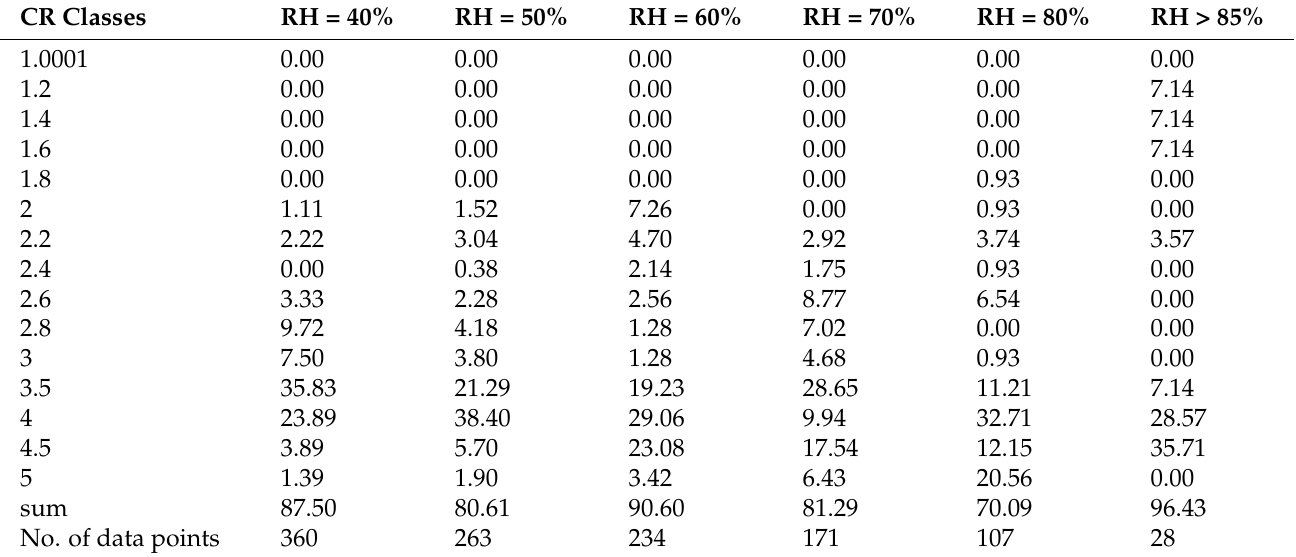
Table A2. Relative frequencies of the colour ratio between 1500 and 2000 m for different RH